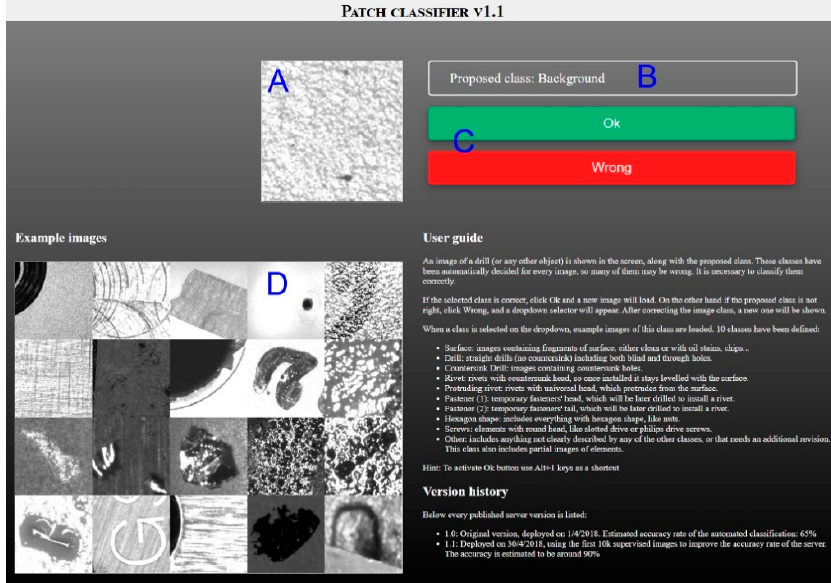
Figure 5. Graphical interface for patch classification purposes. ( A ) the interface presented the patch image to be classified ;( B ) the category proposed by the automatic labeling algorithms; ( C ) it offered the user two options: accept the proposed label or reject it; ( D ) the application presented images of all the categories.